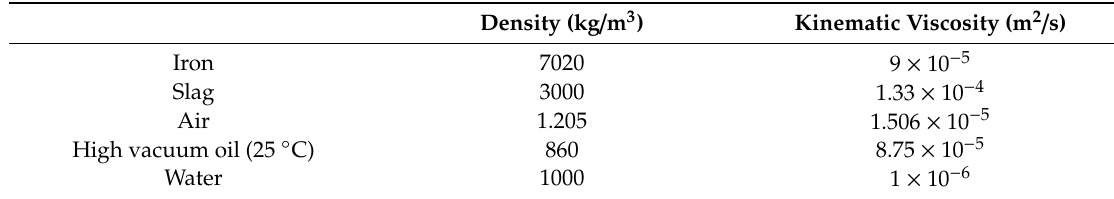
Figure 2. Schematic diagram of the C-H 2 smelting reduction model apparatus. Table 1. Physical parameters of the experiment.